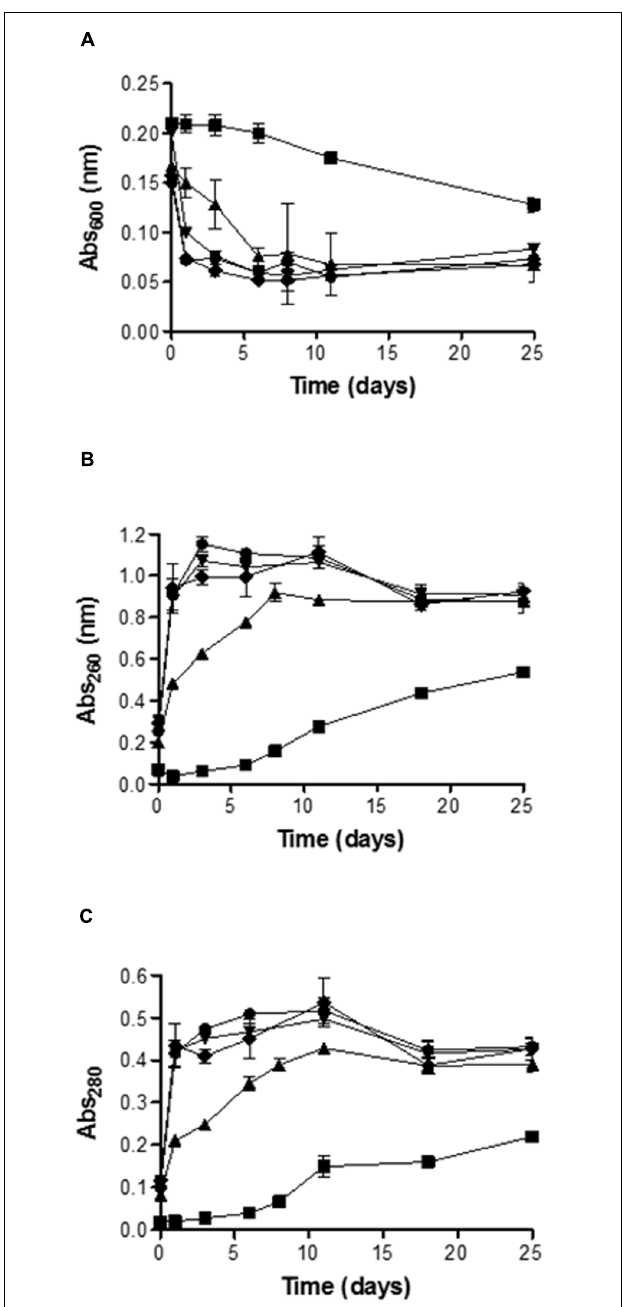
FIGURE 4 | Evolution along the time of the absorbance at 600-nm (A), 260-nm (B) and 280-nm (C) of the medium containing untreated and PEF treated cells of S. cerevisiae. Untreated ( (cid:4) ), 15 kV/cm 45 µ s ( (cid:78) ), 15 kV/cm 150 µ s ( (cid:72) ), 25 kV/cm 45 µ s ( (cid:7) ), 25 kV/cm 150 µ s ( • ).